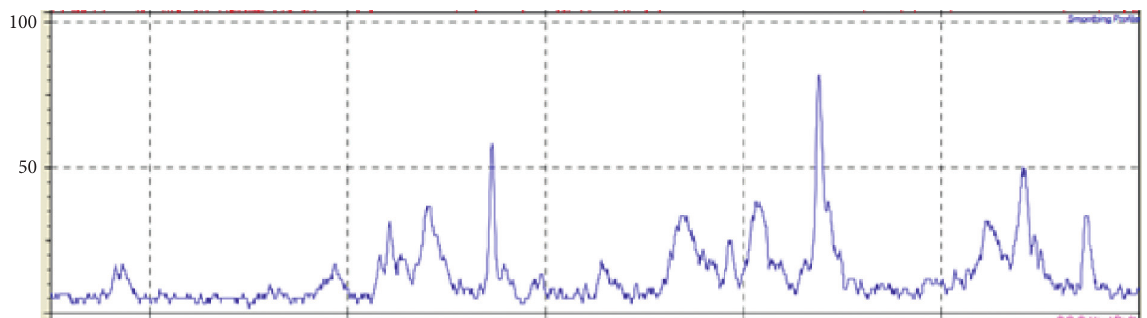
Figure 2: XRD spectrum of crab shell hydroxyapatite